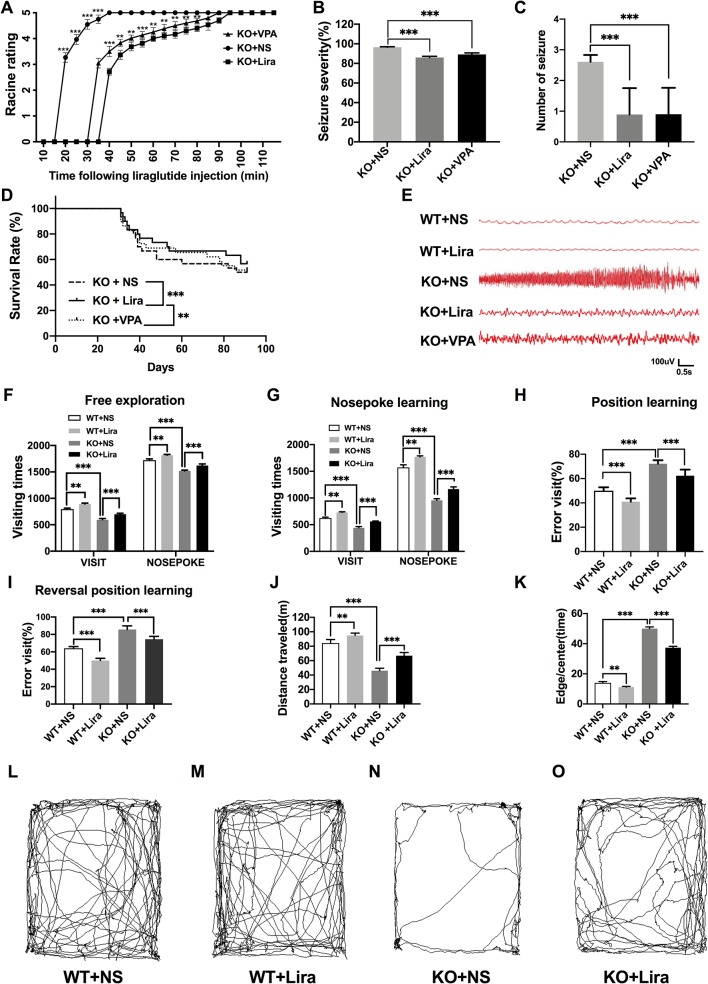
Effects of liraglutide on behavioral performance in Scn1a KO-induced epileptic mice. (A) Behavioral seizure progression on the racine scale (N = 24 mice per group; Two-way ANOVA). (B) The total seizure severity evaluation (N = 24 mice per group; Student’s t-test, P < 0.001). (C) The number of seizures daily in each group over the duration of the experiment (N = 24 mice per group; Student’s t-test, P < 0.001). (D) Survival curves showing a statistically significant difference in survival in each group over the duration of the experiment (N = 24 mice per group; One-way ANOVA, Student’s t-test). (E) A representative EEG recording of seizure activity in the WT and Scn1a KO mice. (F) Free exploratory (N = 24 mice per group; Two-way ANOVA, Student’s t-test). (G) Number of visits and nosepoke in nosepoke learning (N = 24 mice per group; Two-way ANOVA, Student’s t-test). (H) Number of correct visits in position learning (N = 24 mice per group; One-way ANOVA, Student’s t-test). (I) Number of correct visits in reversal position learning (N = 24 mice per group; One-way ANOVA, Student’s t-test). (J) Significant impairment was found in total distanced traveled (N = 24 mice per group; One-way ANOVA, Student’s t-test). (K) Significant impairment was found in total Edge/Centre time (N = 24 mice per group; One-way ANOVA, Student’s t-test). (L–O) Difference in thigmotaxis behavior between NS and Lira in WT or Scn1a KO mice was found, respectively, which was shown in a computer-generated trace of the animal’s movements over 10 min. Data were presented as mean ± SD; **, *** represent P < 0.01, and P < 0.001, respectively. All experiments were performed in triplicate. WT, Wild-type; KO, Scn1a Knockout heterozygotes (F1); NS, Normal saline; Lira, Liraglutide.